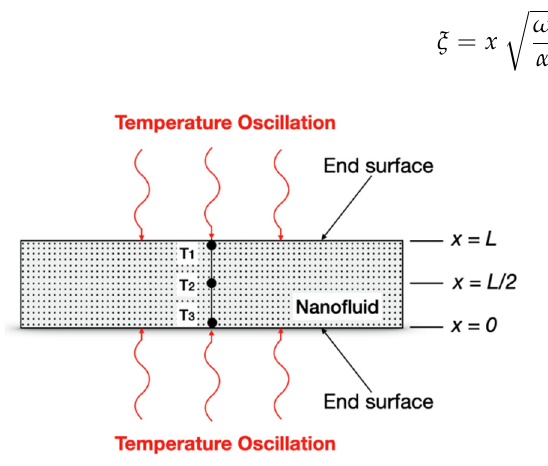
Figure 9. Diagram of the thermal conductivity measurement system with temperature oscillation technique (adapted from Bhattacharya et al. (2004) [82]).